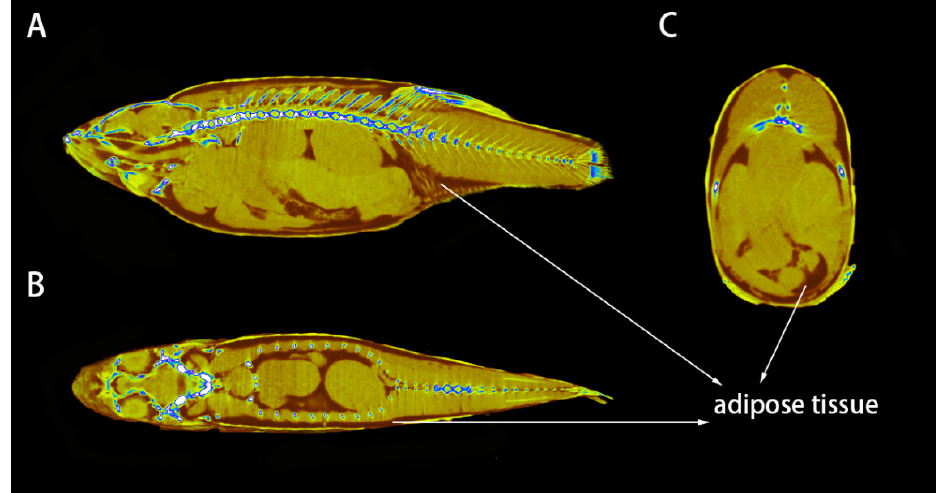
Figure 9. 3D color rendering created using the CTvox 3D viewing software. ( A ) Sagittal plane; ( B ) Coronal plane; ( C ) Axial